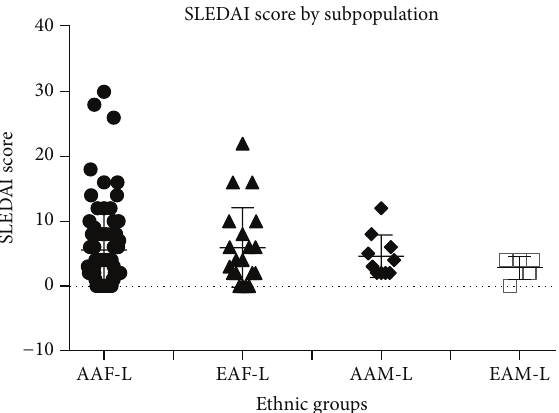
Figure 1: SLE disease activity index (SLEDAI) by population. African American (AAF-L) and European American (EAF-L) women with lupus have the highest SLEDAI scores compared to African American and European American men with lupus.